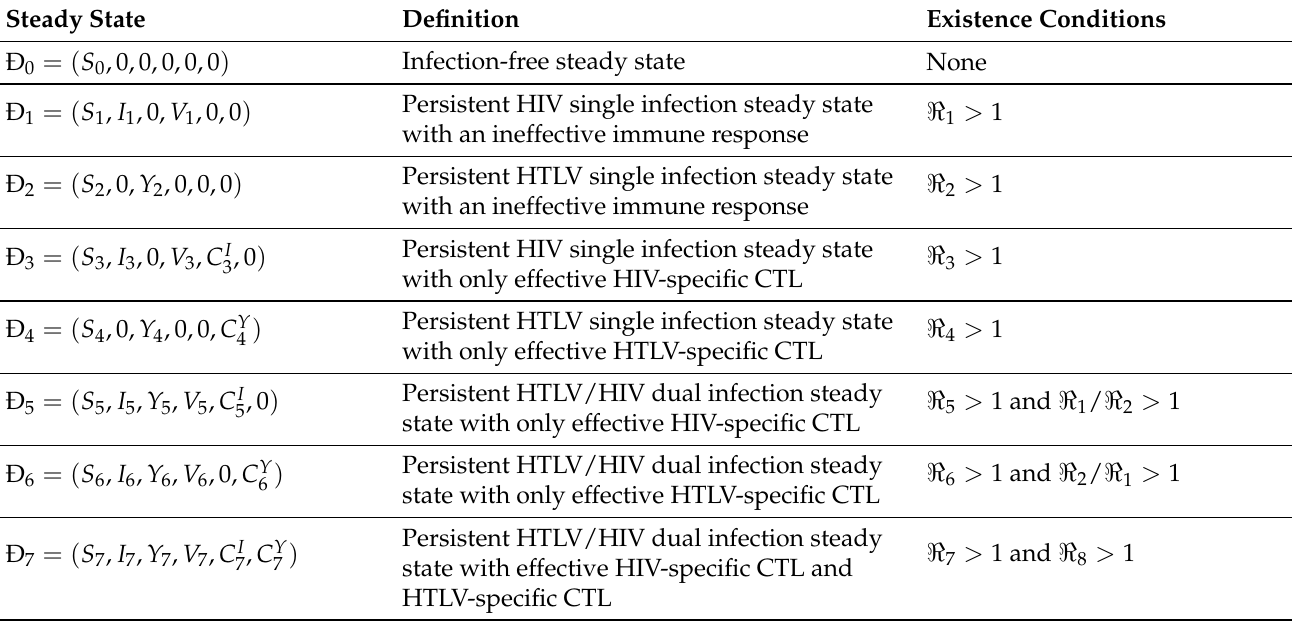
Table 1. Model (4) equilibria and their existence